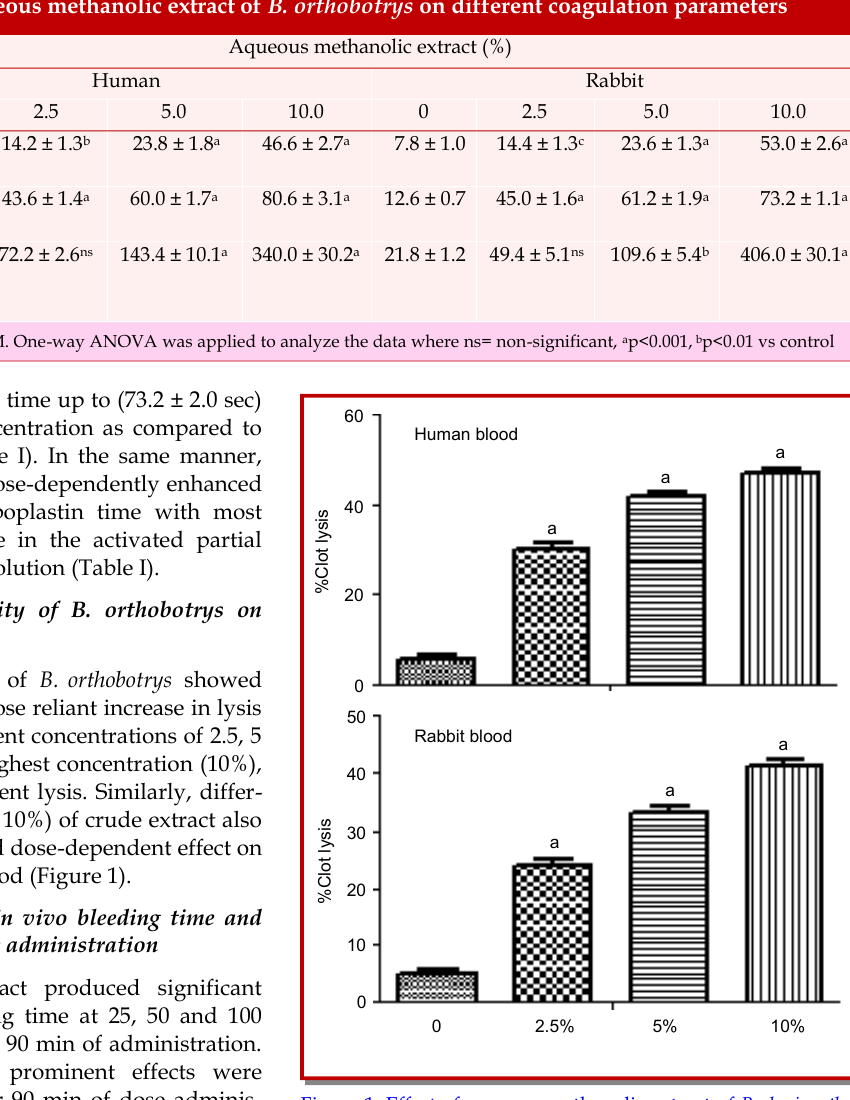
Figure 1: Effect of aqueous methanolic extract of Berberis ortho- botrys on human (upper) or rabbit (lower) blood clot lysis done by One-way ANOVA where a